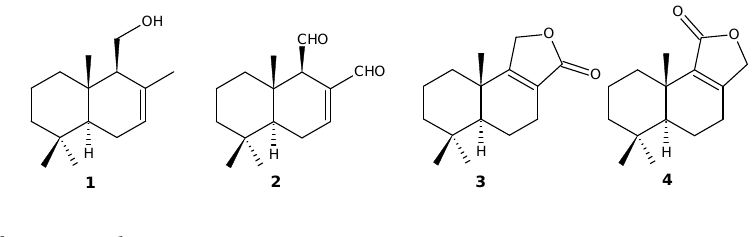
Figure 3. Compounds characterized from the D. winteri dichloromethane